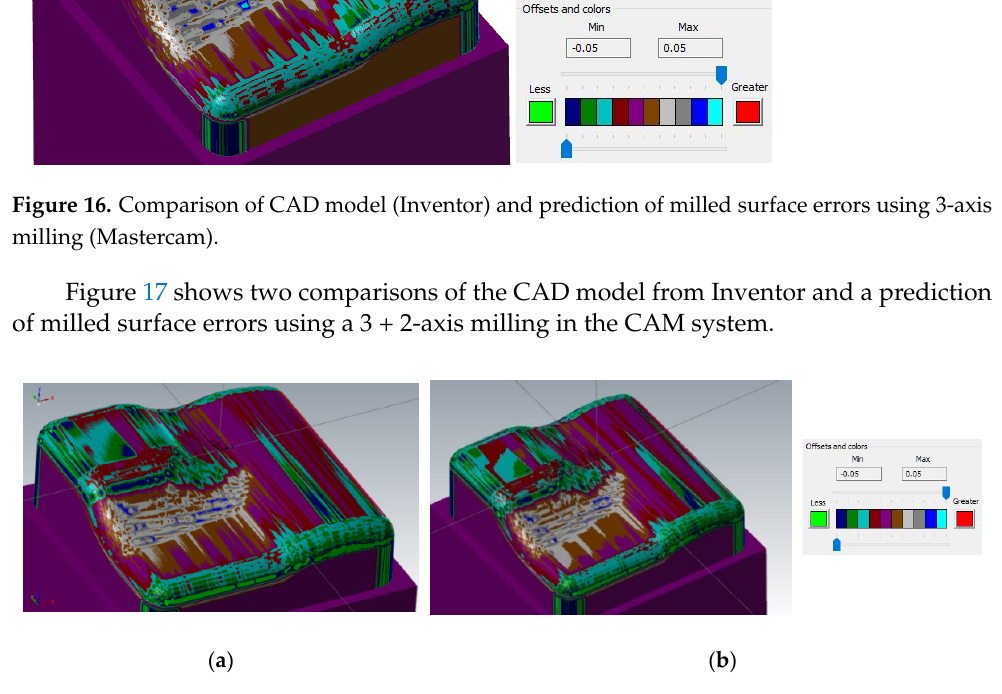
Figure 17. Comparison of the CAD model (Inventor) and the prediction of milled surface errors using 3 + 2-axis milling (Mastercam), ( a ) tool inclination β f = 20°, β n = 0°, ( b ) tool inclination β f = 10°, β n = 20°).